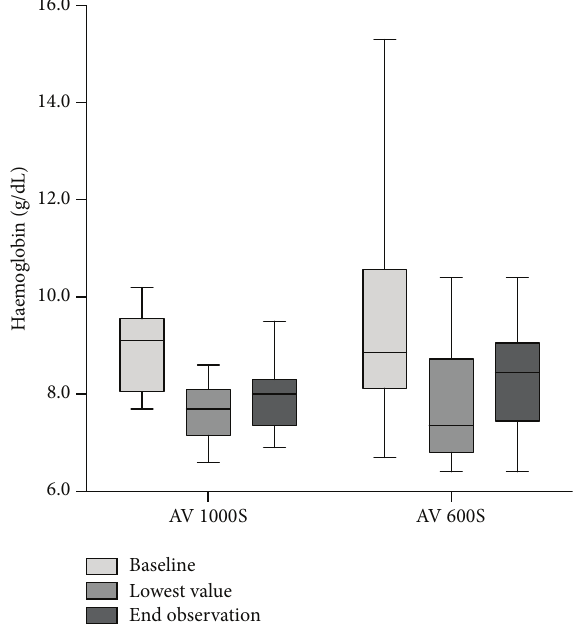
Figure 3: Changes in haemoglobin concentrations with